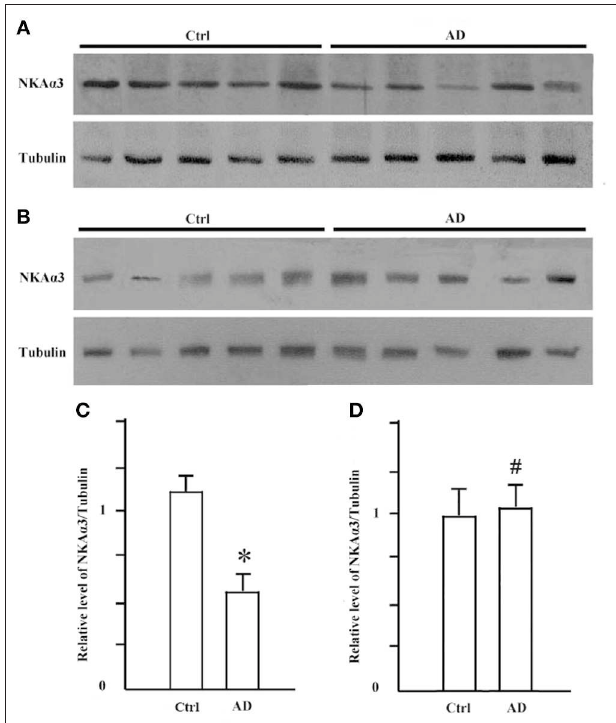
FIGURE 5 | The levels of NKA α 3 protein were decreased in PSD fractions of human AD cortex. Synaptosome and PSD fractions were prepared from 5 case human AD and 5 case control frontal cortical tissues. 20 µ g proteins of each fraction were used for western blot. (A) NKA α 3 proteins in PSD fractions were detected by western blot. (B) NKA α 3 proteins in synaptosome fractions were detected by western blot. (C) Relative amount of NKA α 3 proteins in control PSD at 1.10 ± 0.10 show decrease to 0.58 ± 0.09 in AD. Each value is expressed as mean ± SEM. n = 5, * p < 0.05. (D) Relative amount of NKA α 3 proteins in synaptosome fractions show no significant difference. Each value is expressed as mean ± SEM. n = 5, # p >